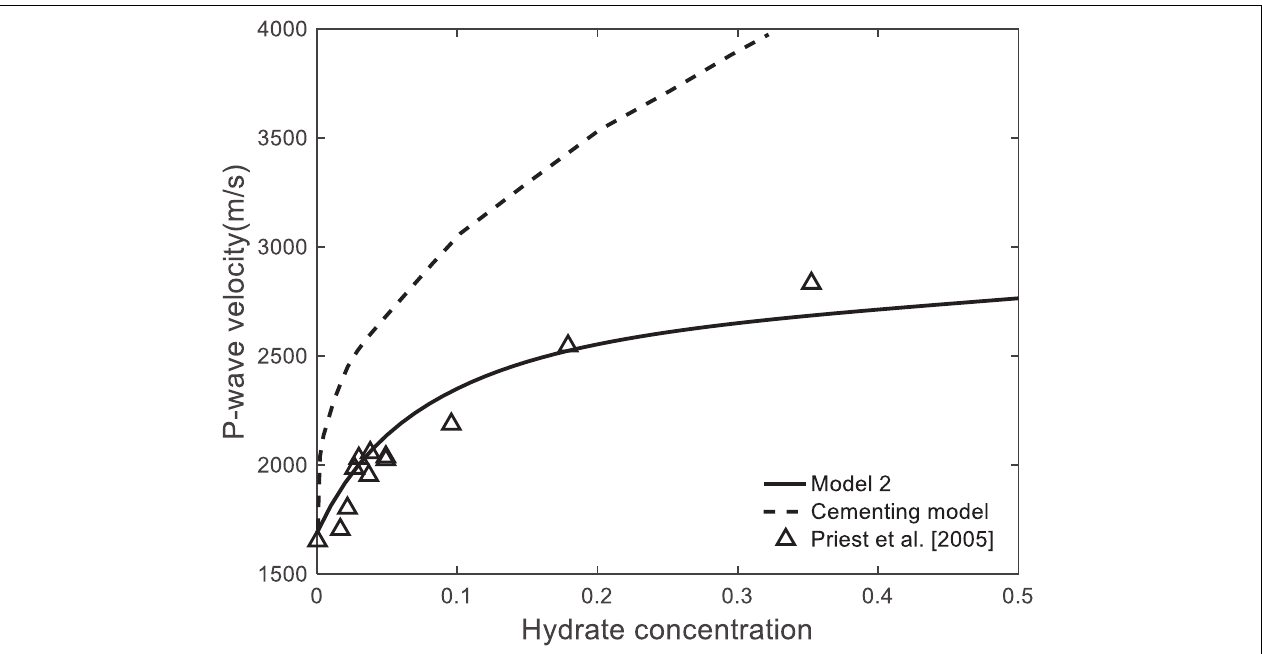
FIGURE 13 | Model 2. P-wave velocity as a function of hydrate concentration. The frequency is around 200 Hz. The cementing-model curve and experimental data (triangles) are taken from Priest et al. (2005).